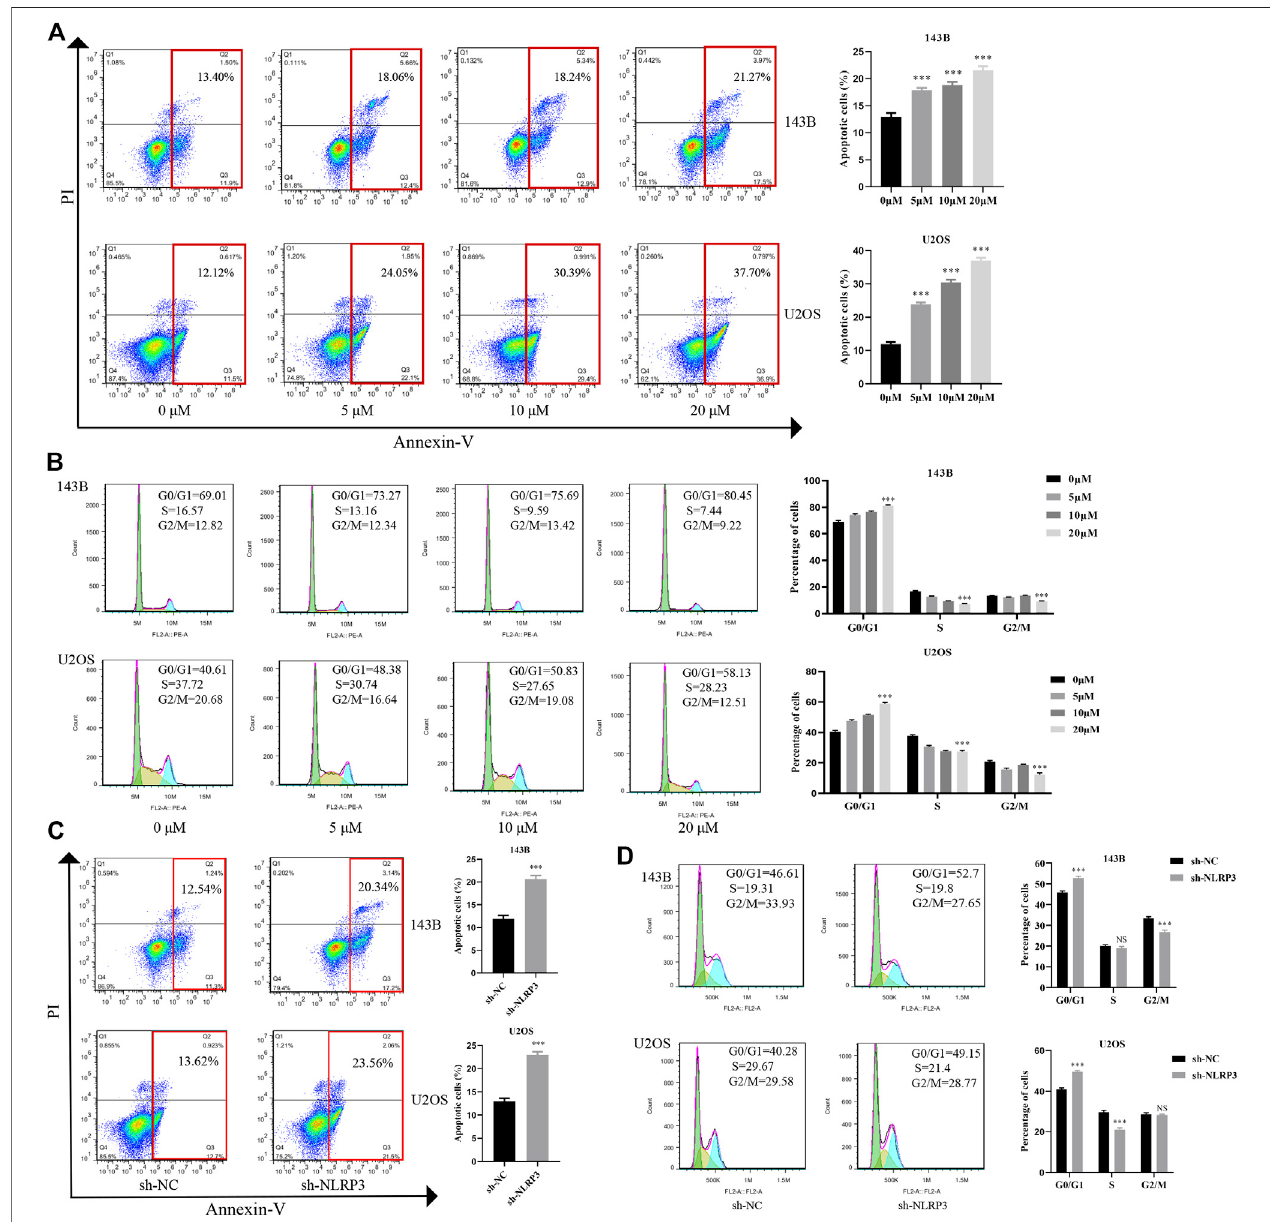
FIGURE 5 | Effect of NLRP3 inhibition on cell apoptosis and cell cycle changes in osteosarcoma (A) The cell apoptosis rate of 143B and U2OS cells treated with differentconcentrationsofCY-09detectedusingthe fl owcytometry (B) Cellcycledistributionof143BandU2OScellstreatedwithdifferentconcentrationsofCY-09was detected using the fl ow cytometry (C) The rate of cell apoptosis of lentivirus-transfected 143B and U2OS cells assessed using the fl ow cytometry (D) The cell cycle distribution of lentivirus-transfected 143B and U2OS cells was assessed using the fl ow cytometry. The experiments were conducted in triplicate.